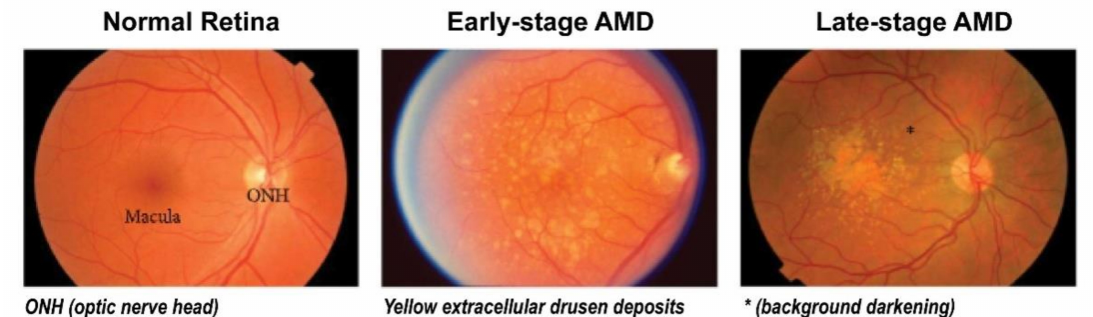
Figure 1. Clinical stages of age-related macular degeneration (AMD). Early-stage AMD shows yellow extracellular drusen deposits surrounding macular area. Late-stage AMD shows hypopigmentation or background darkening (*) around drusen, and a large number of drusen deposits are observed accumulated in the macular area. Adapted with permission from Jiangyuan et al.